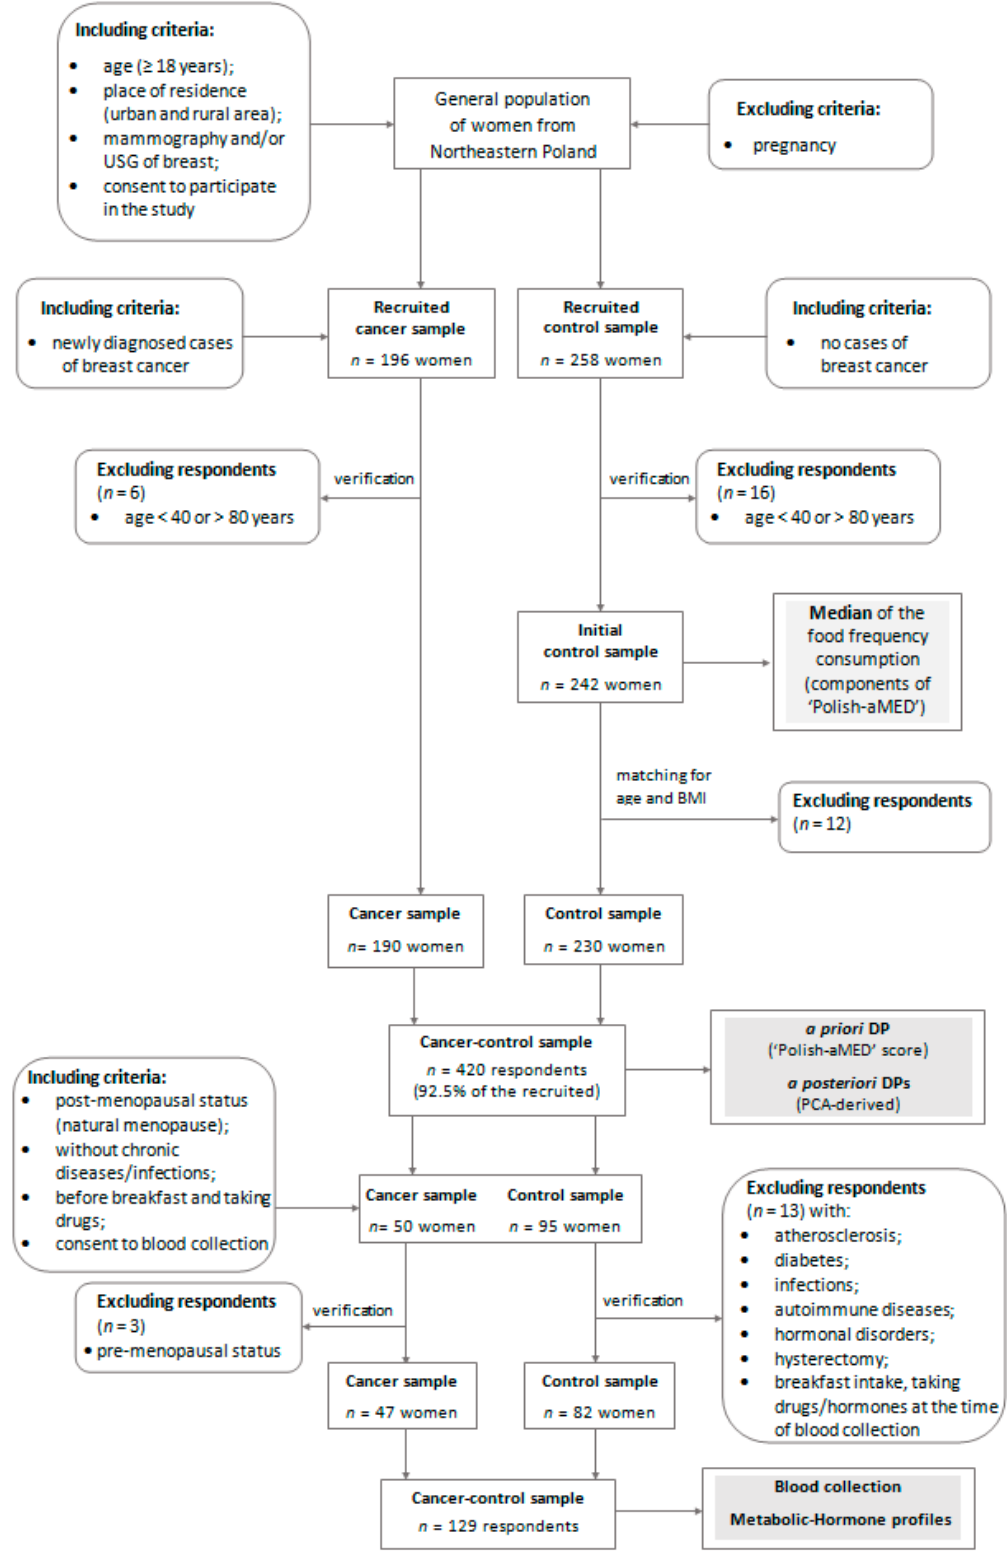
Figure 2. Diagram of the study design and sample collection. BMI—Body Mass Index; USG—ultrasonography; DP—dietary pattern; ‘Polish-aMED’—‘Polish-adapted Mediterranean Diet’; PCA—Principal Component Analysis; The stages of the study are shaded.